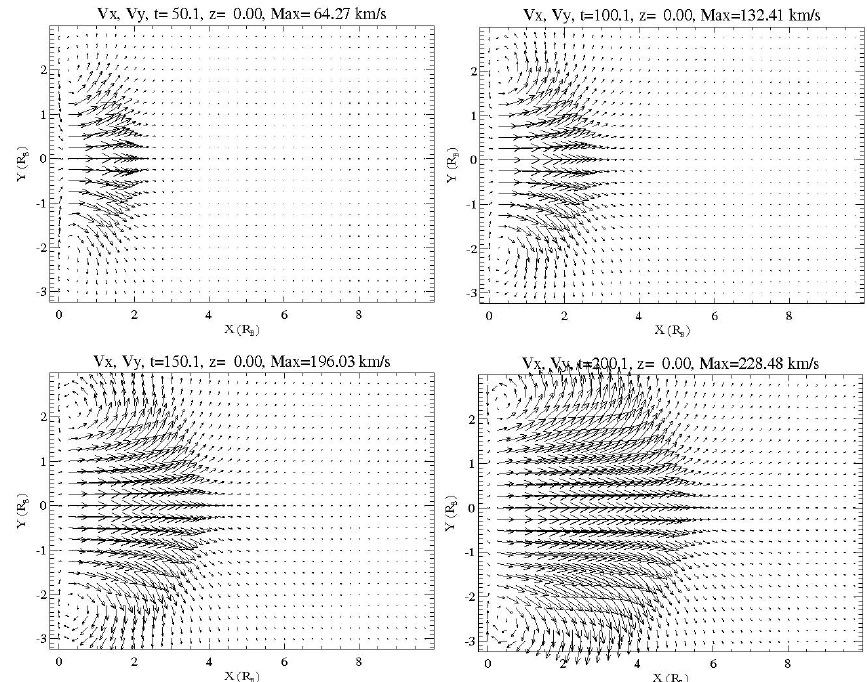
Fig. 2. Velocity vectors in the z =0 plane at 50, 100, 150, and 200s into the run.